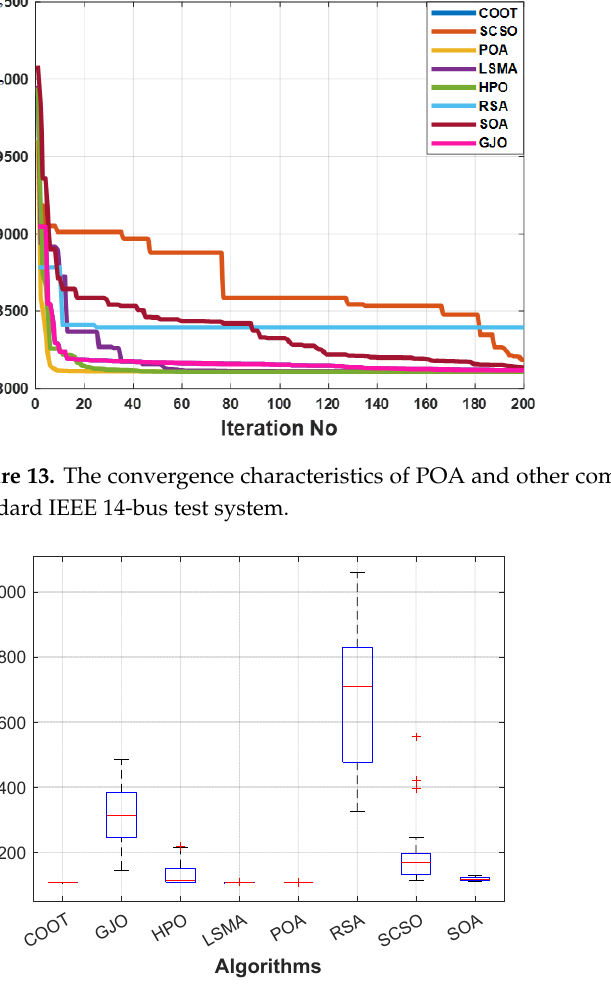
Figure 14. Boxplot of POA and other compared algorithms for case 4 in a standard IEEE 14-bus test system.